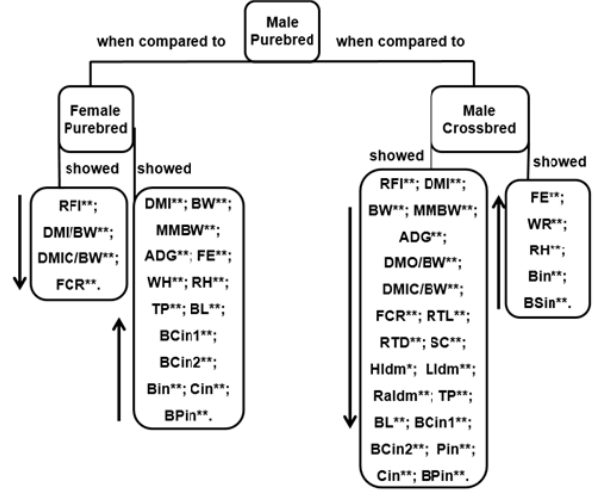
Figure 1. Comparison between means of